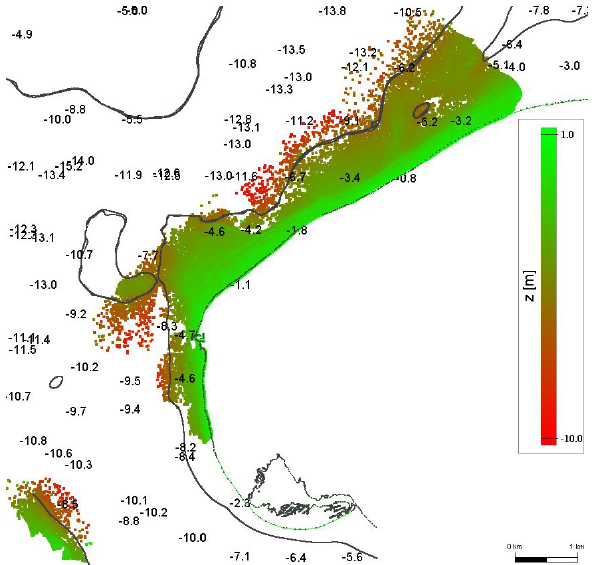
Figure 7: Depth of sea bed points (Area 4) with 5m isobath.